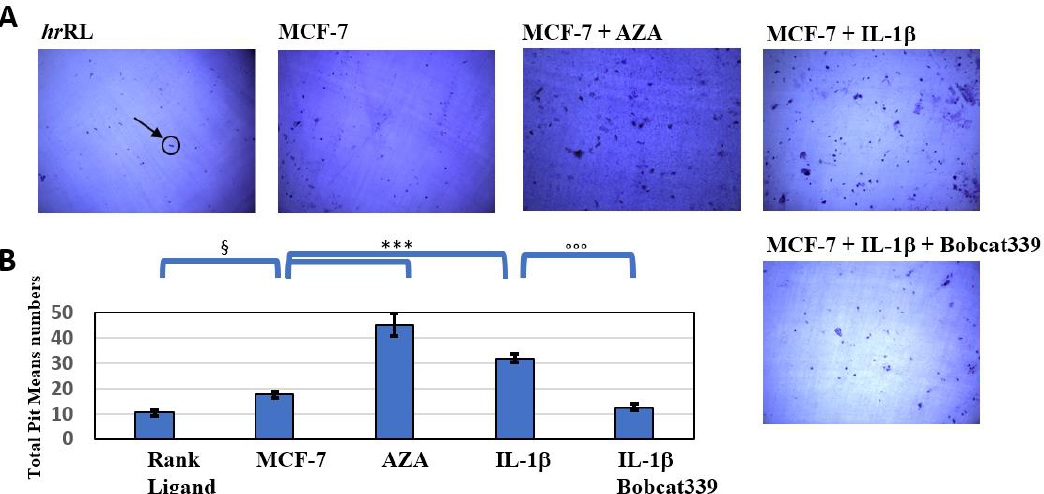
Figure 6. Bobcat339 hampers formation of lacunae on dentine slices. Bone resorption pit assay of Raw264.7 cells seeded on dentine discs and treated for 5 days with 25 ng/mL of hrRank Ligand or with the conditioned medium from MCF-7 cells (untreated or treated with IL-1 β , AZA, or IL-1 β /Bobcat339). ( A ) Representative images of lacunae formed (dark areas, as indicated by the arrow). ( B ) Data relative to the mean numbers of total pits formed by mature osteoclasts. One-way ANOVA showed significant effect of treatment on number of pit measured on dentins; significant differences among tested treatments versus hrRL (§), untreated MCF-7 (*), and among IL-1 β /BC co-treatments versus the IL-1 β one ( ◦ ) are reported in the graphs (§, p < 0.05; *** and ◦◦◦ , p < 0.0005).